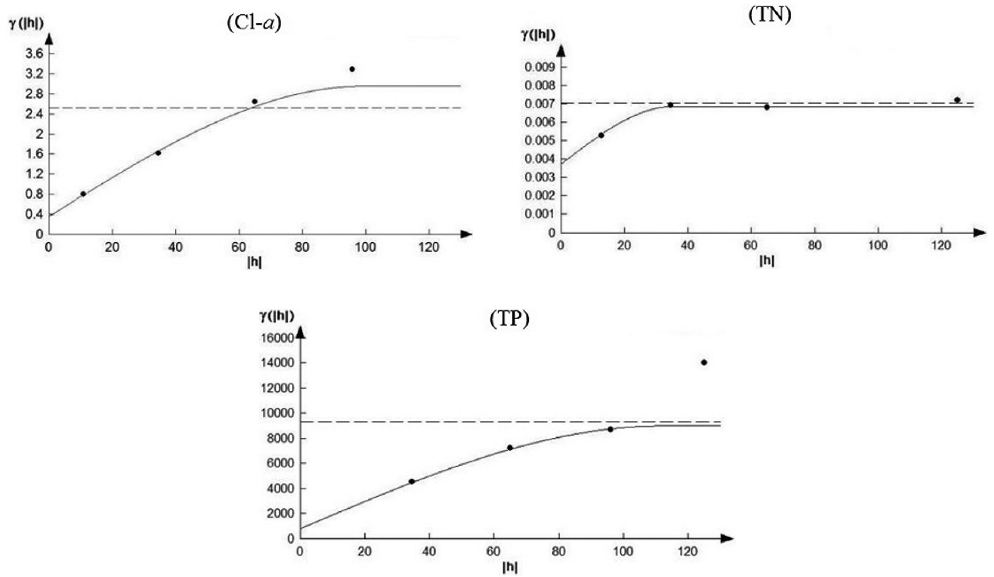
Figure 4. Semivariograms of chlorophyll- a (Cl- a ), total nitrogen (TN) and total phosphorus (TP).